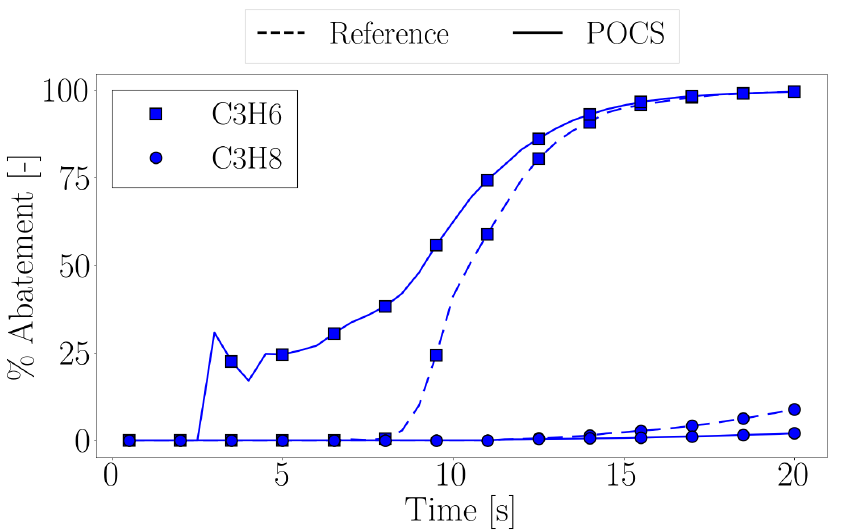
Figure 21. Cold start assessment: HC percentage abatement